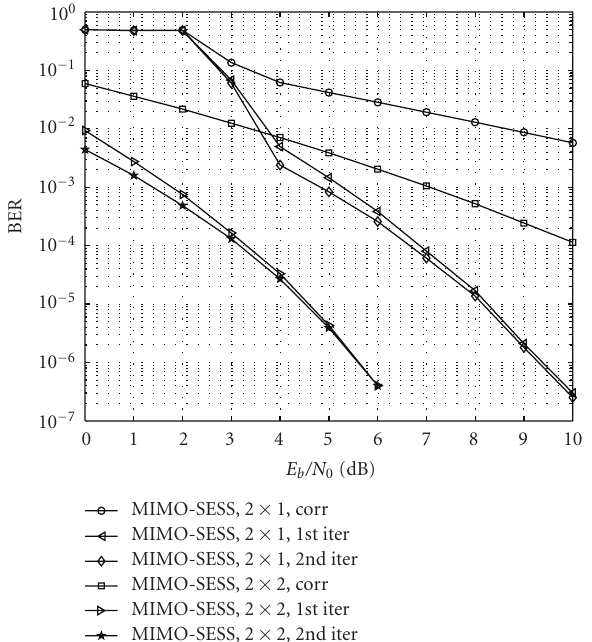
Figure 6: Performance of the proposed MIMO-SESS system with iterative detection, four transmit antennas using half-rate code G 4 , N = 64.